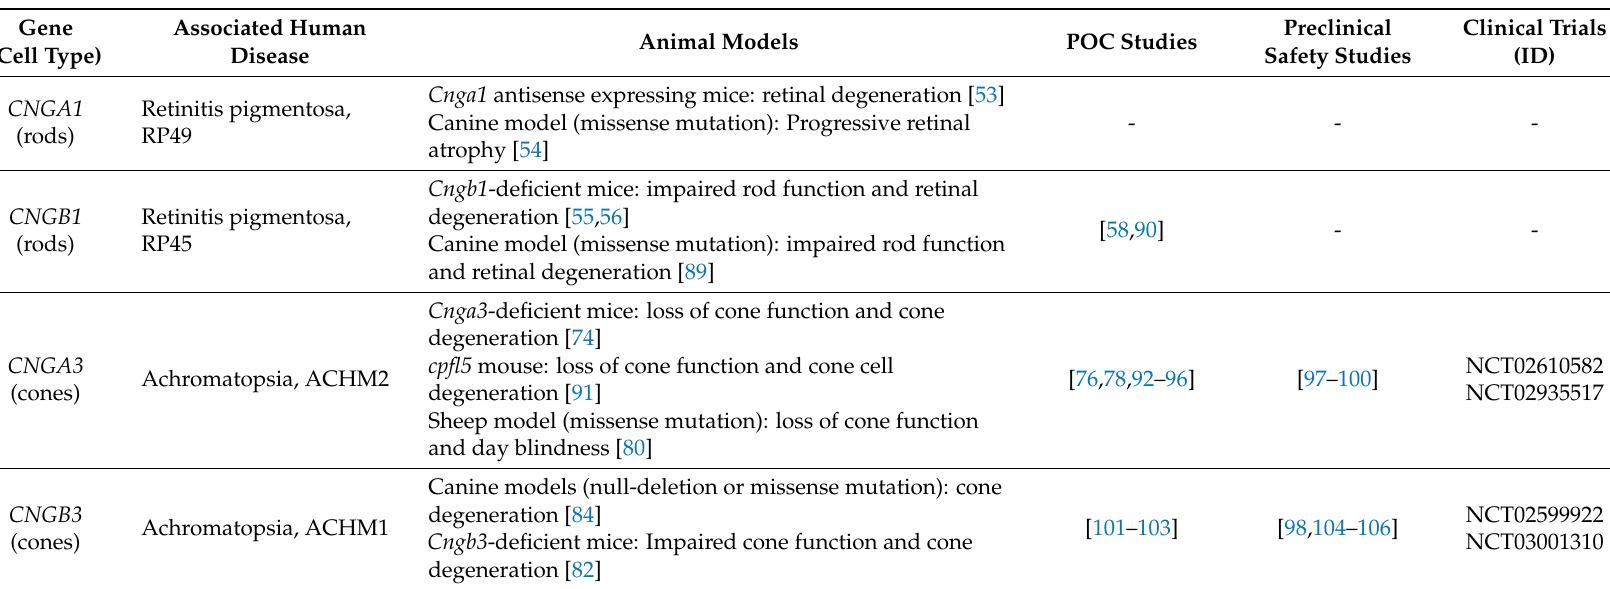
Table 1. Overview of retinal CNG genes, associated human diseases, animal models, preclinical and clinical gene therapy studies. ID, www.clinicaltrials.gov identifier. POC,